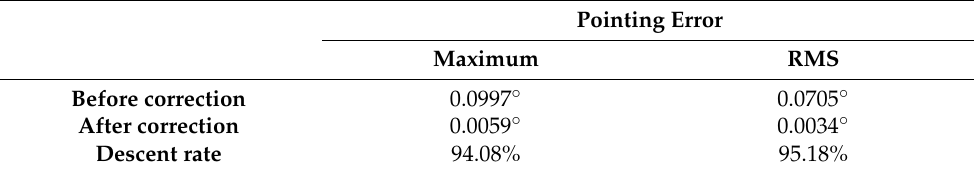
Figure 13. Comparison of the inverse solution error before and after correction in the experiment. ( a ) Before correction. ( b ) After correction. Table 6. Experimental results of inverse solution error correction.